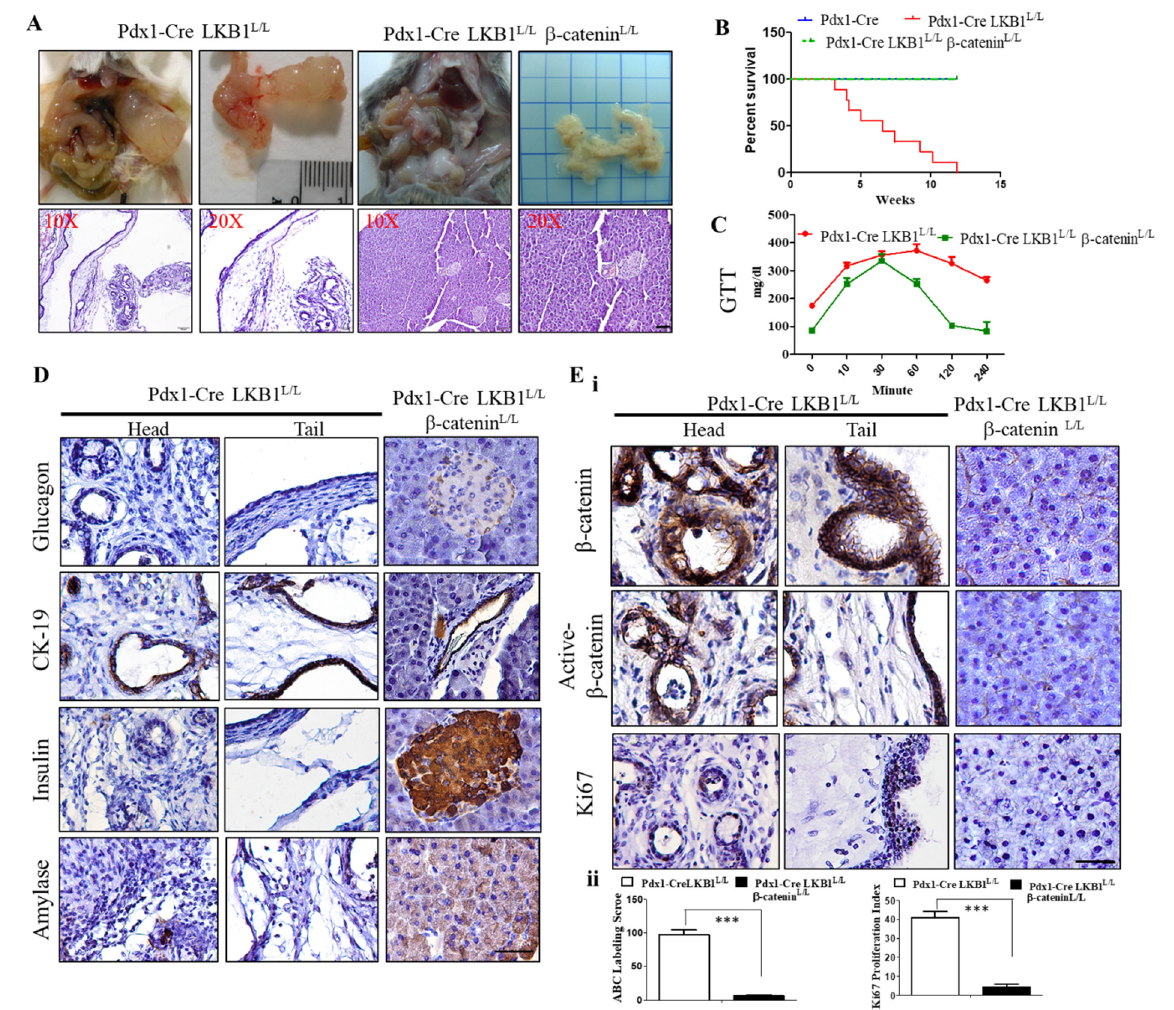
Figure 4. Conditional depletion of β -catenin impairs LKB1 loss-driven MCN formation in mice. ( A ). Gross anatomy of the pancreas and H&E-stained examination of the pancreata of Pdx-1Cre LKB1 L/L and Pdx-1Cre LKB1 L/L β -catenin L/L mice. The latter displays a completely normal pancreas architecture and function. Scale bar is 100 µ m. ( B ). Kaplan–Meier analysis of β -catenin loss significantly extends tumor-free survival in Pdx-1Cre LKB1 L/L β -catenin L/L mice. ( C ). Depletion of β -catenin in LKB1 loss-driven cysteadenoma mice restores the normal blood glucose concentration, as determined by a GTT test. p < 0.01. ( D ). Immunohistological sections from 20-week-old Pdx1-Cre LKB1 L/L and Pdx1-Cre LKB1 L/L β -catenin L/L mice stained with antibodies to insulin, glucagon, and amylase and with CK19. Scale bar is 100 µ m. ( E ). ( i ) IHC staining for total and active β -catenin and Ki67 in pancreata from Pdx-1CreLKB1 L/L mice versus Pdx1-Cre β -catenin L/L LKB1 L/L mice. Scale bar is 100 µ m. ( ii ) The active β -catenin (ABC) labeling score and Ki67 positive cells were quantified per field. Values given are the means ± SE from 6 random sections for each sample. *** p <